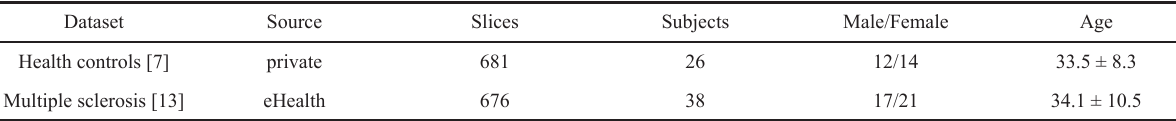
Table 1. Demographic characteristics of the